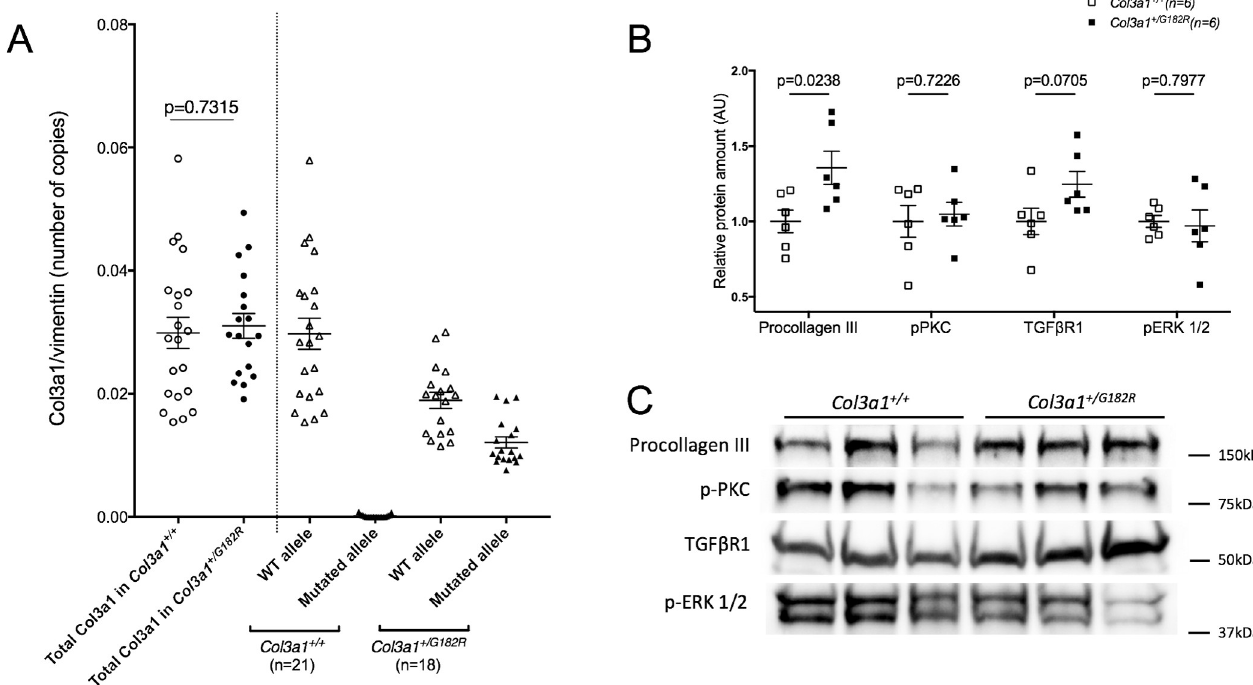
Fig 4. Expression of Col3a1 gene and collagen III in aortas of Col3a1 +/G182R mice. A Relative allele specific mRNA expression of type III collagen in thoracic aorta of Col3a1 +/+ (n = 21) and Col3a1 +/G182R (n = 18) 24-week-old mice of both sexes determined by ddPCR. The total expression of the Col3a1 gene was evaluated (a: unpaired student t-test). The expression of the mutated allele, harboring the Glycine substitution, was not significantly different than the expression of the WT allele in Col3a1 +/G182R mice, (b: comparative test between theoretical and observed proportions). Furthermore the absence of expression of the mutated allele in Col3a1 +/+ mice confirmed the specificity of the probe of the mutated allele. B Quantification of procollagen III, p-ERK, p-PKC, and TGF β 1R levels with western blot analysis, using total protein normalization in Col3a1 +/G182R (n = 6) and Col3a1 +/+ (n = 6) mice. C Corresponding representative Western blot analysis of proteins of TGF- β /Smad and MAPK/ERK signaling pathways: procollagen III, p-ERK, p-PKC and TGF β 1R to compare their expression in Col3a1 +/+ and Col3a1 +/G182R mice.